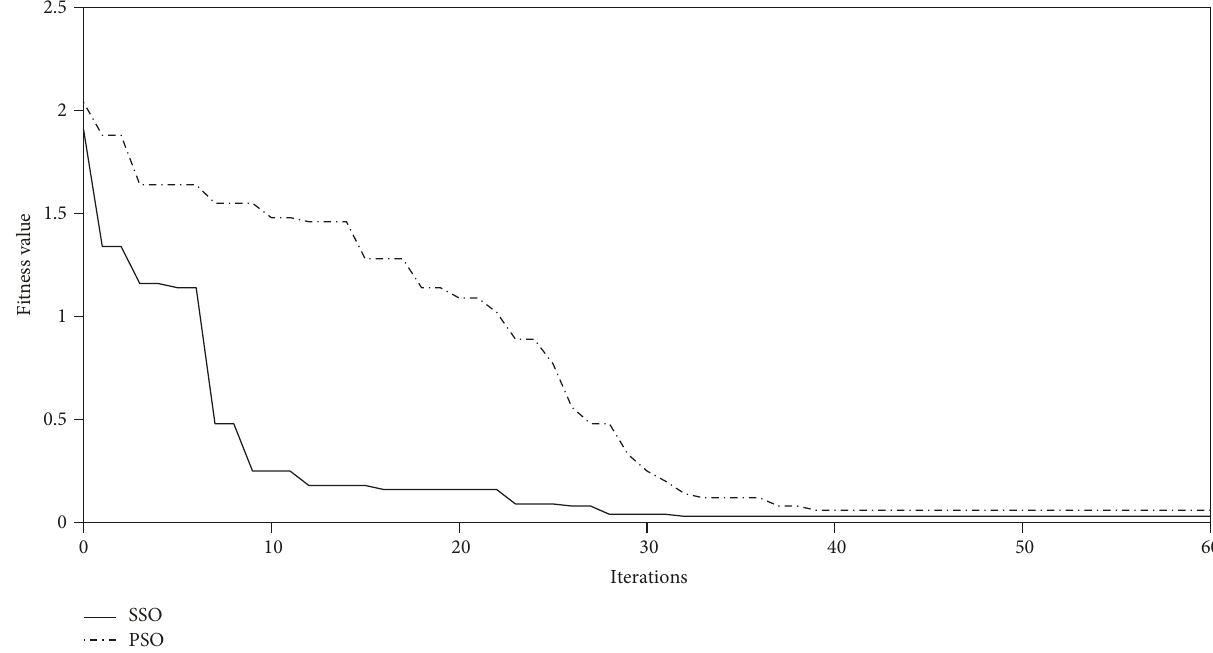
Figure 11: Simulation results for the re fl ection coe ffi cient dependence of the inset feed width X with the shorting post.